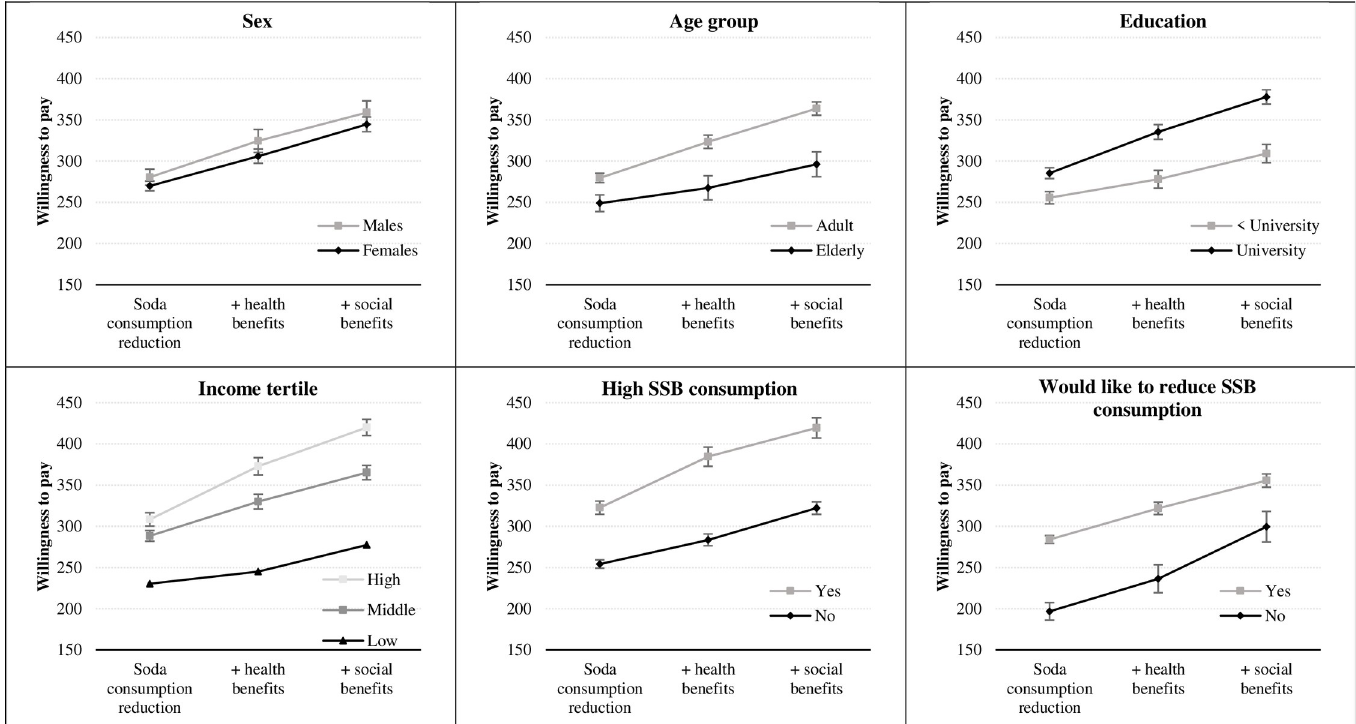
Fig 1. Average willingness to pay for an intervention that reduces soda consumption, by scenario and variable.